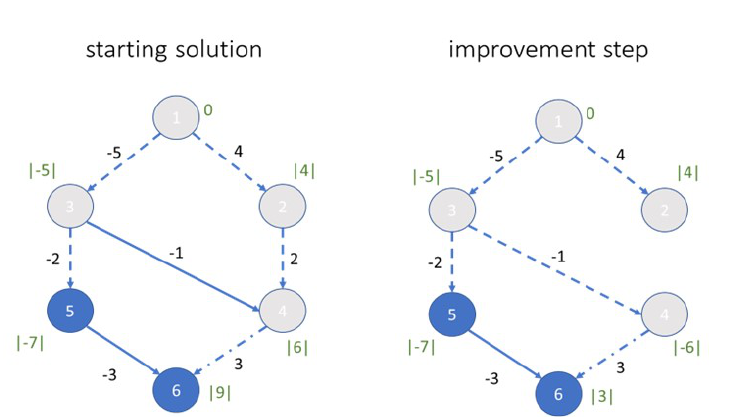
Figure 3. An example of IPa .